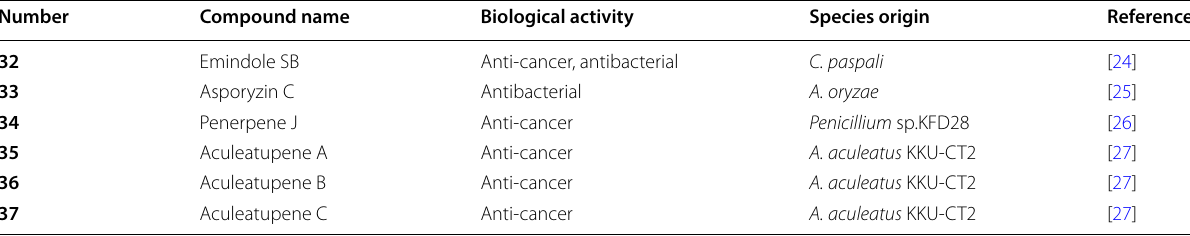
Table 2 Name, bioactivities and source of emindole SB